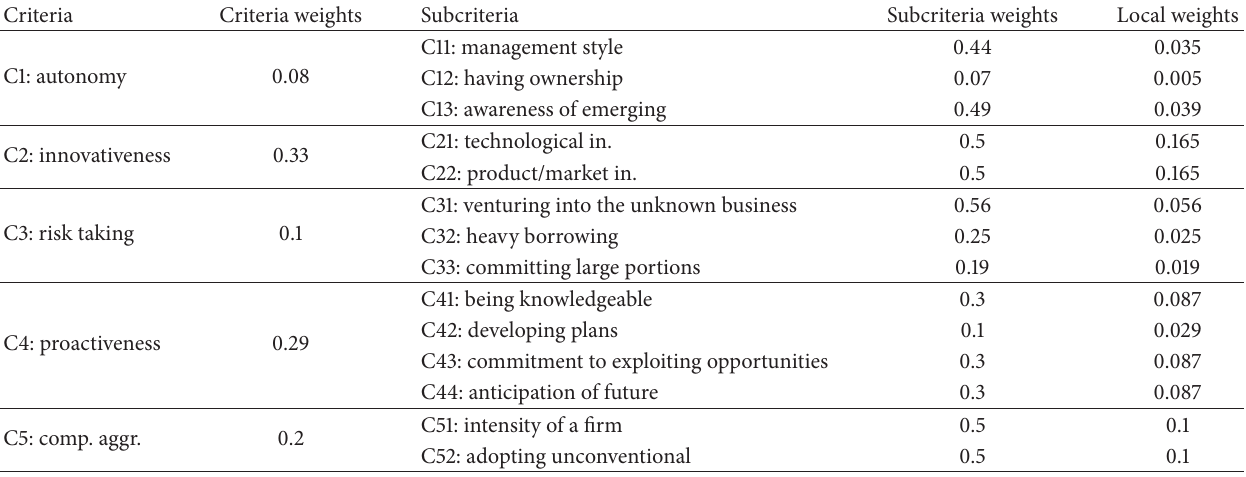
Table 5: Final weights of criteria and subcriteria using FAHP.